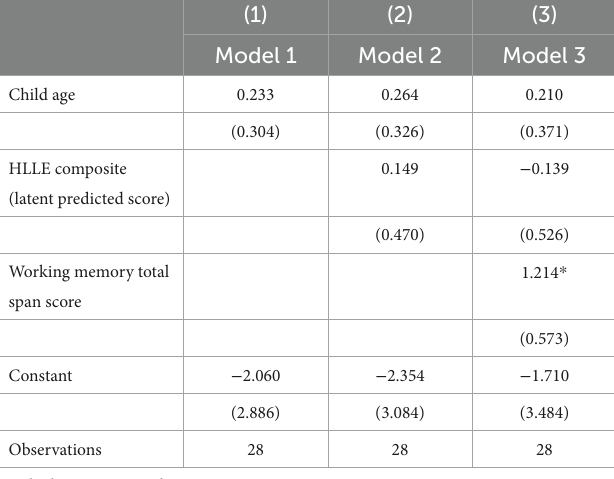
TABLE 3 Stepwise logistic regression for factors that predict reading progress